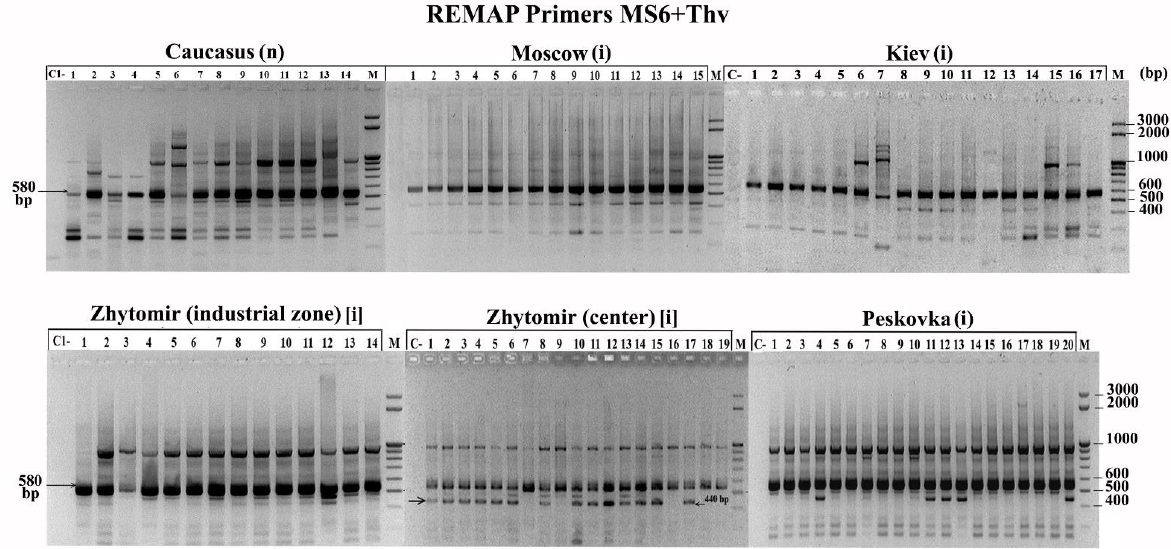
Figure 4. REMAP profile with the MS+Thv19 primers for H. sosnowskyi . (i)—invasive population, (n)—native population.